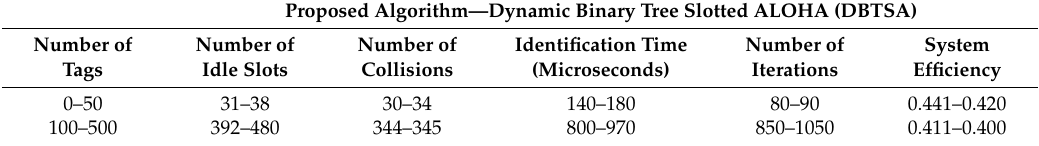
Table 1. Summarized